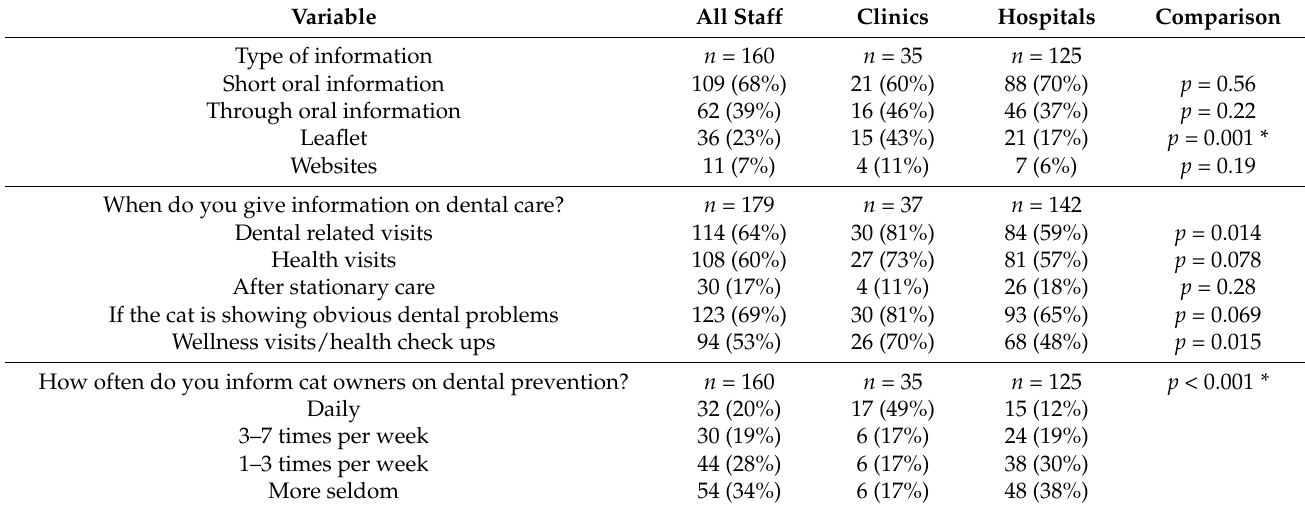
Table 6. Veterinary care staff responses on what type of information they provide to their cat-owning clients when this information is given and the frequency of this routine. The p -value for statistical significance was adjusted for variables where several answers were allowed and several tests performed, using the Bonferroni correction to avoid incorrect significance testing results due to multiple testing (one correction per question: p -value for statistical significance = 0.05/4 = 0.013 and 0.05/5 = 0.01, respectively). * indicates statistically significant difference between type of veterinary facility